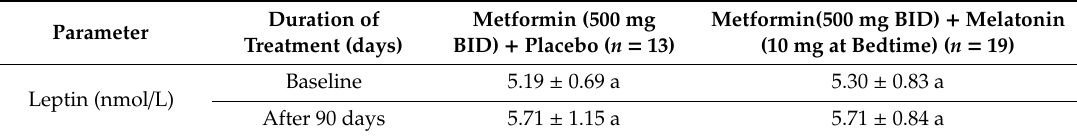
Table 3. E ff ect of treatment with metformin–melatonin versus metformin-placebo on the serum leptin level in MEBS